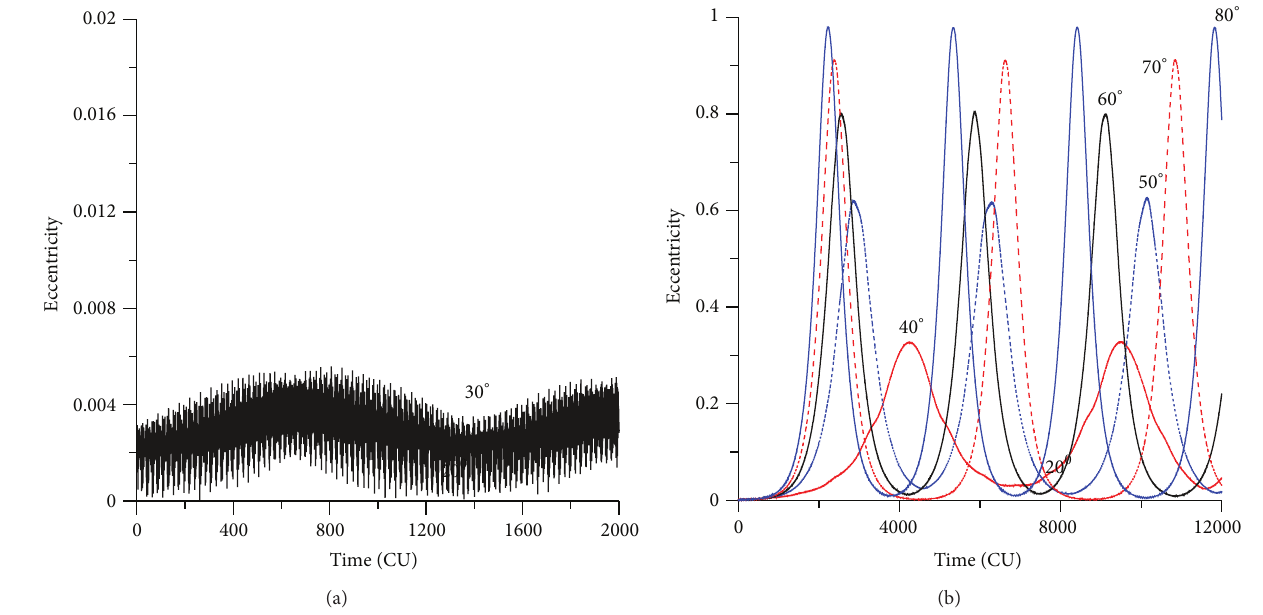
Figure 7: Evolution of the eccentricity for circular and direct orbits (exact model). The initial conditions are a = 0.341 canonical units, e (0) = 0, 𝜔 (0) = 0, and Ω (0) =